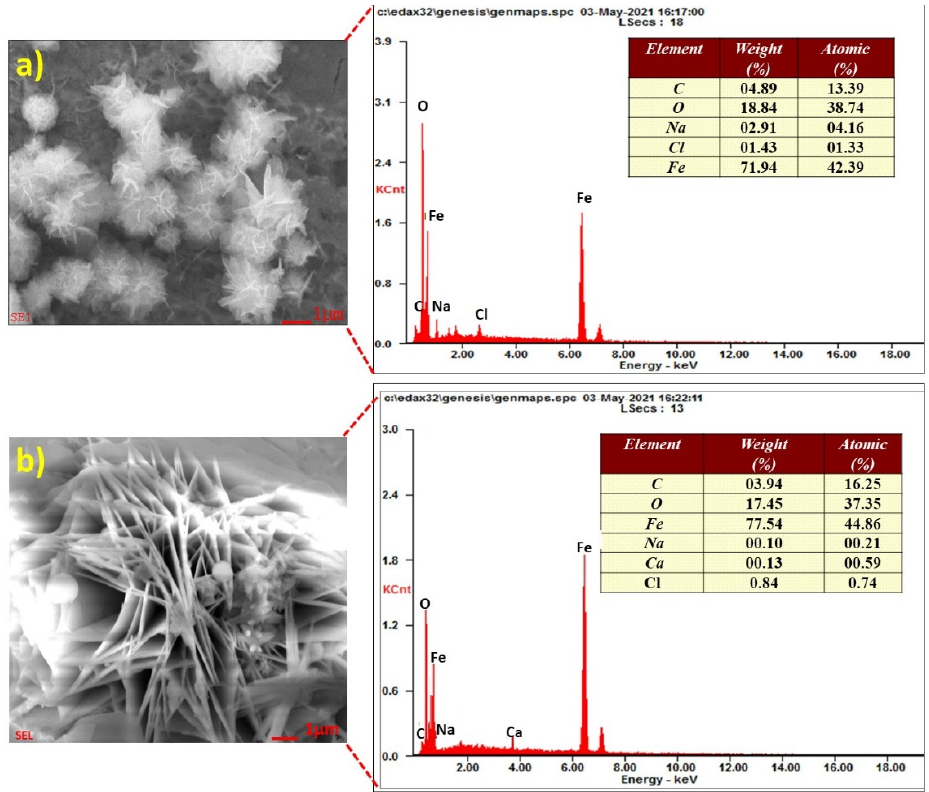
Figure 11. EDS analysis of the corrosion products on the steel rebar surface after an exposure period of 30 days [O-SSSA0 ( a ); and O-SSA20 ( b )].